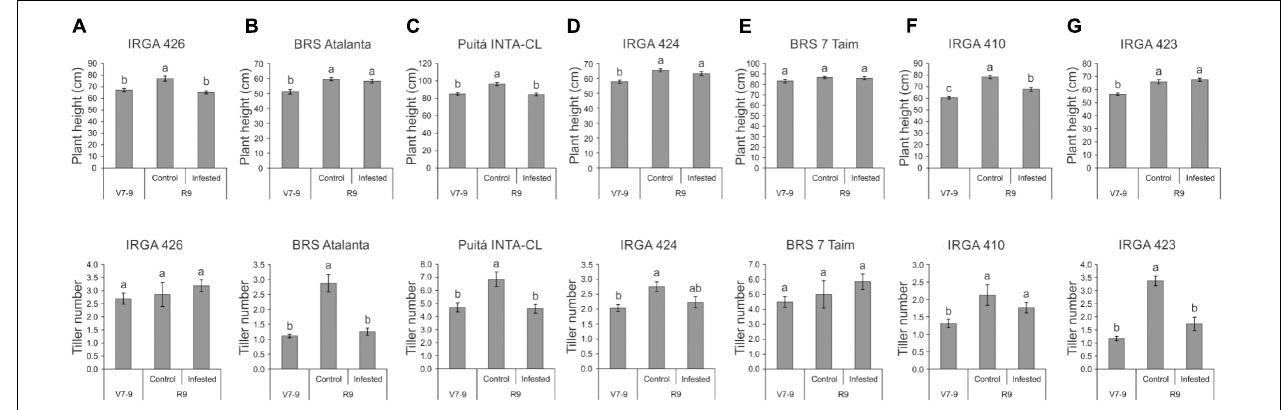
FIGURE 1 | Plant height (cm) and tiller number of the seven tested cultivars, (A) IRGA 426, (B) BRS Atalanta, (C) Puitá INTA-CL, (D) IRGA 424, (E) BRS 7 Taim, (F) IRGA 410, and (G) IRGA 423, at the vegetative stage (no infestation, V7-9) and full maturity stage (control or infested conditions, R9). Represented values are the averages of 50 samples ± SE. Different letters indicate that the means are different by the Tukey’s HSD test ( P ≤